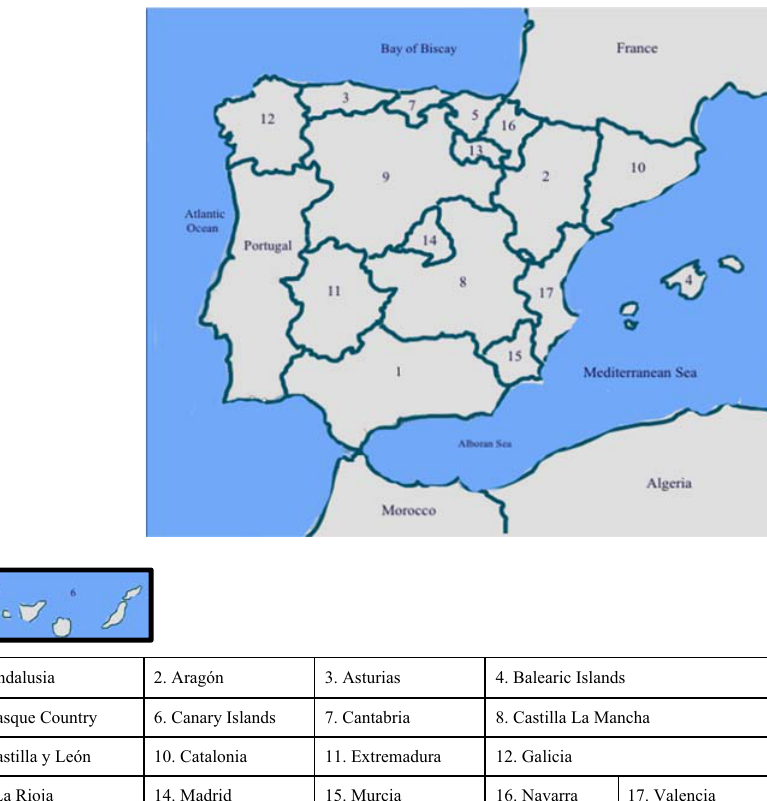
Figure 1. Map of Spain and surrounding